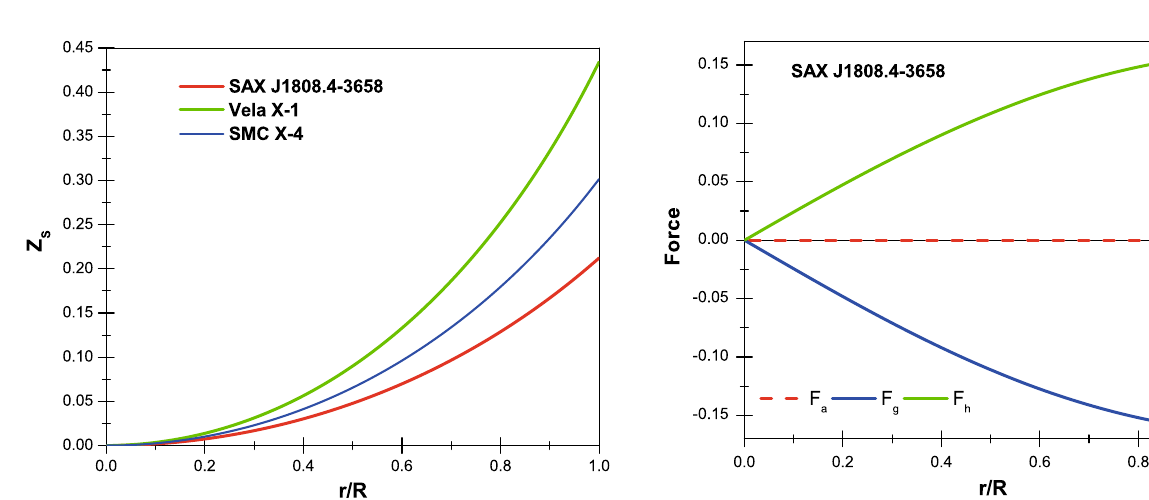
Fig. 14 Dominant energy conditions in both tangential and radial direction, panels a and b respectively